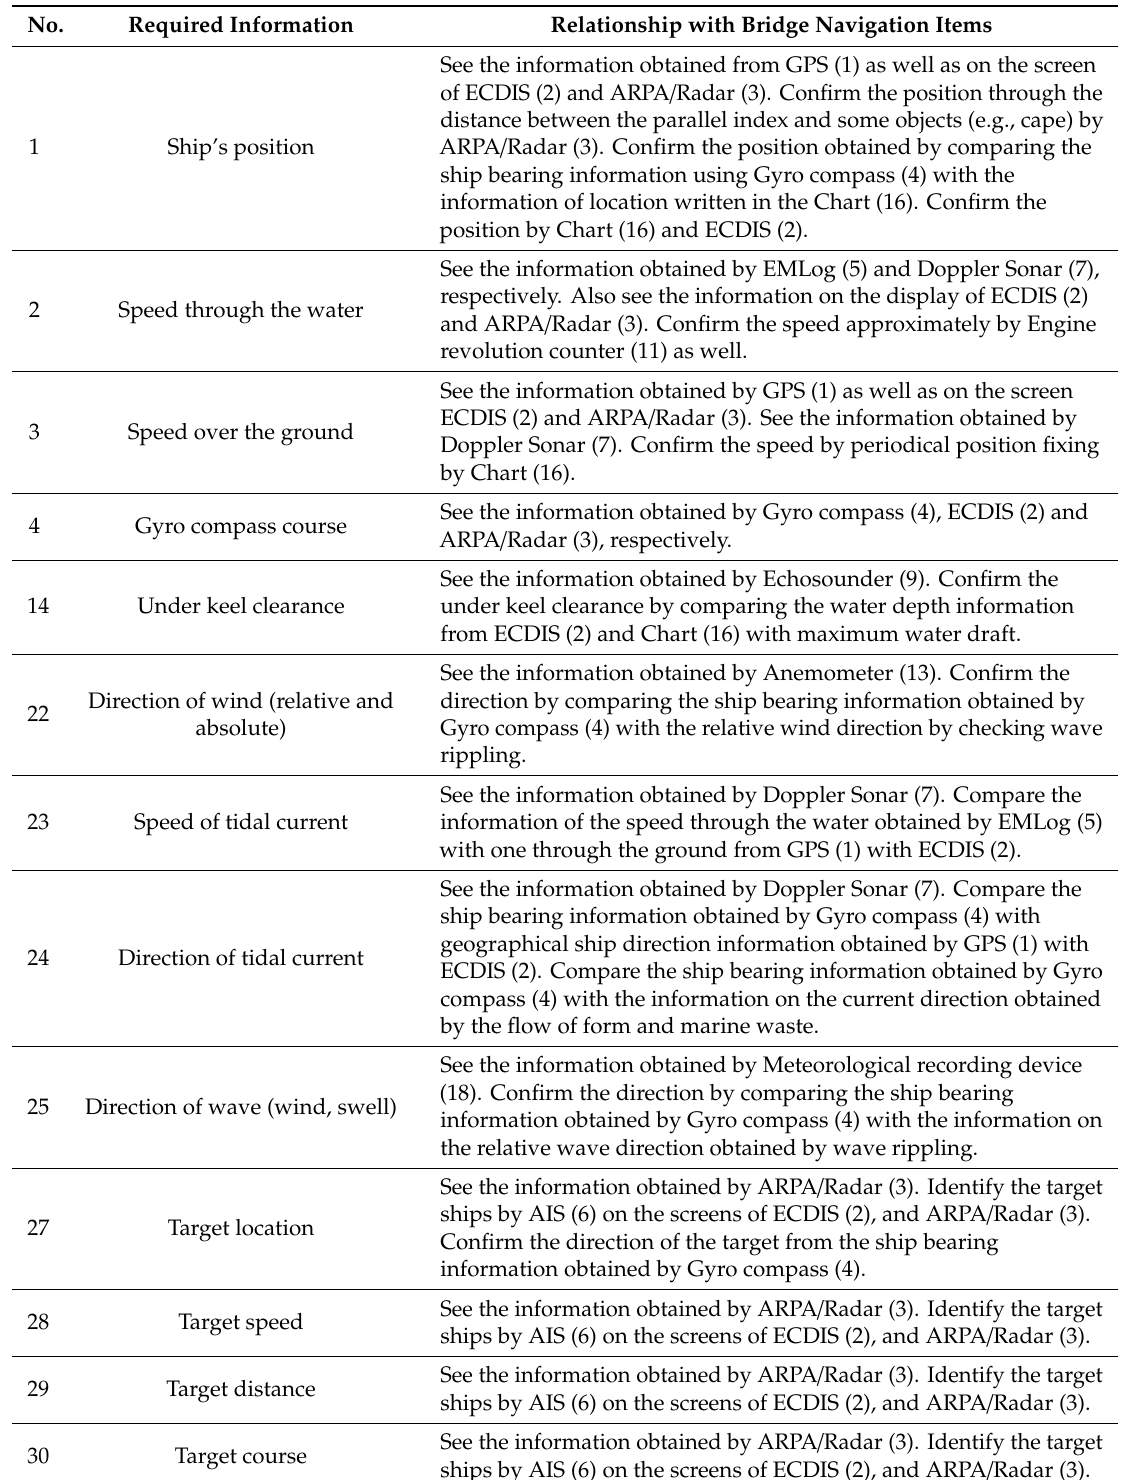
Table 5. Detailed explanation on the relationship between required information for Level 1 SA and information resources (bridge navigation items) (in case that two or more items are